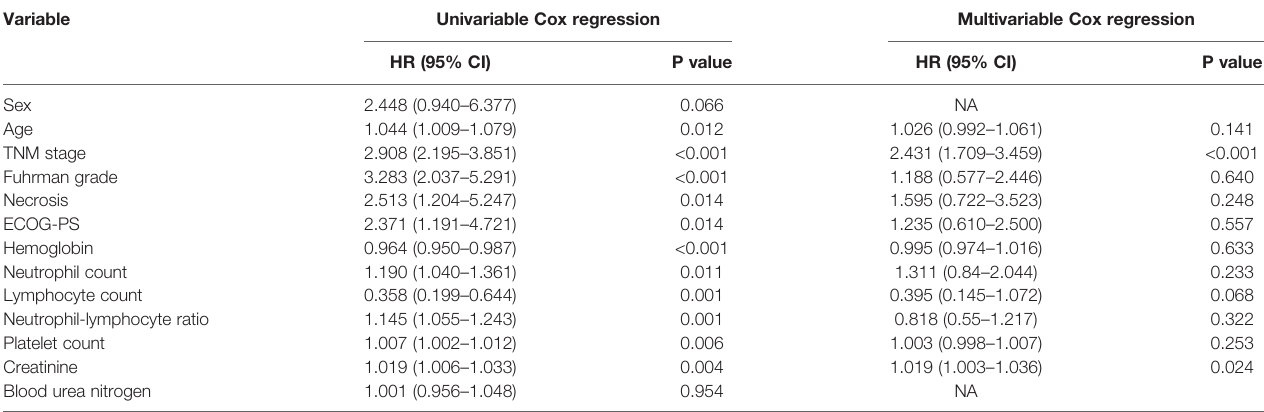
TABLE 2 | Uni- and multivariable COX regression analysis of predictors of OS. Variable